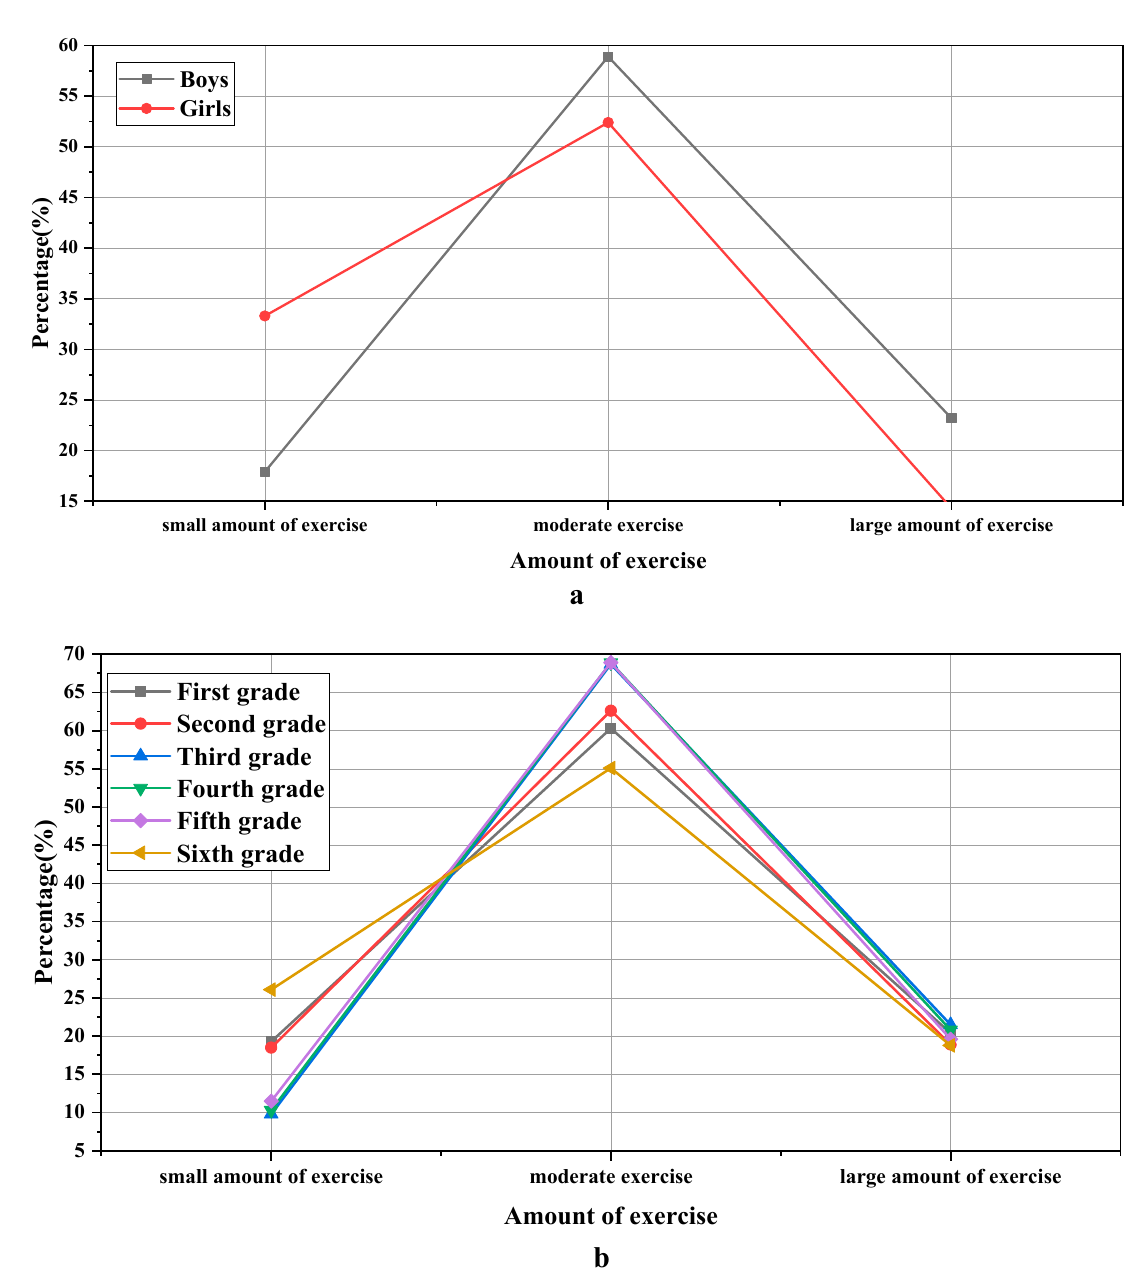
Figure 4. Statistical results of the amount of exercise: ( a ) is the gender classification of the sample; ( b ) is the grade classification of the sample.